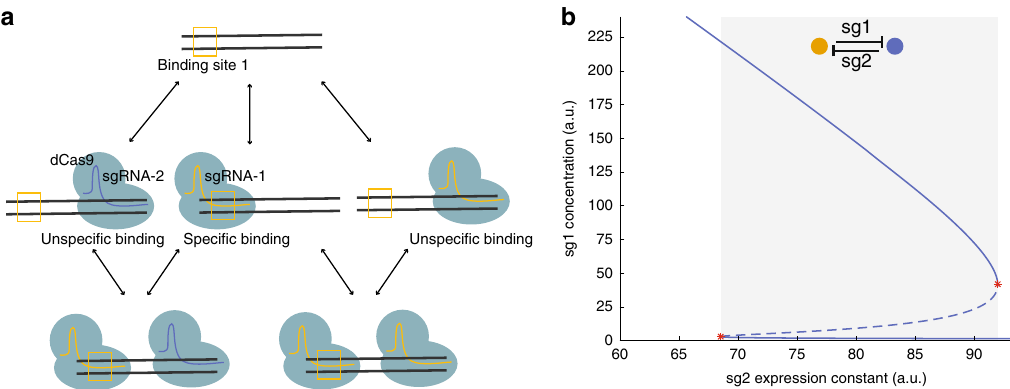
Fig. 3 Proposed origin of bistability in the CRISPRi TS. a Binding con fi gurations of two dCas9/sgRNA variants (colors). We assume a speci fi c binding site for one variant (box) and unspeci fi c binding during screening of PAM sequences for both variants. Arrows: binding/unbinding reactions. b Bifurcation diagram for the mathematical model with speci fi c and unspeci fi c dCas9/sgRNA binding (biologically constrained parameters; see Supplementary Fig. 12 and Supplementary Table 4). Solid (dashed) lines: stable (unstable) steady states; red stars: tangent bifurcations; gray: bistability region. Note that sgRNA- 1 (abbreviated sg1) and sgRNA-2 (sg2) in the model represent two generic sgRNAs, and not necessarily the speci fi c sequences labeled as sgRNA-1 and sgRNA-2 in the experimental parts of this